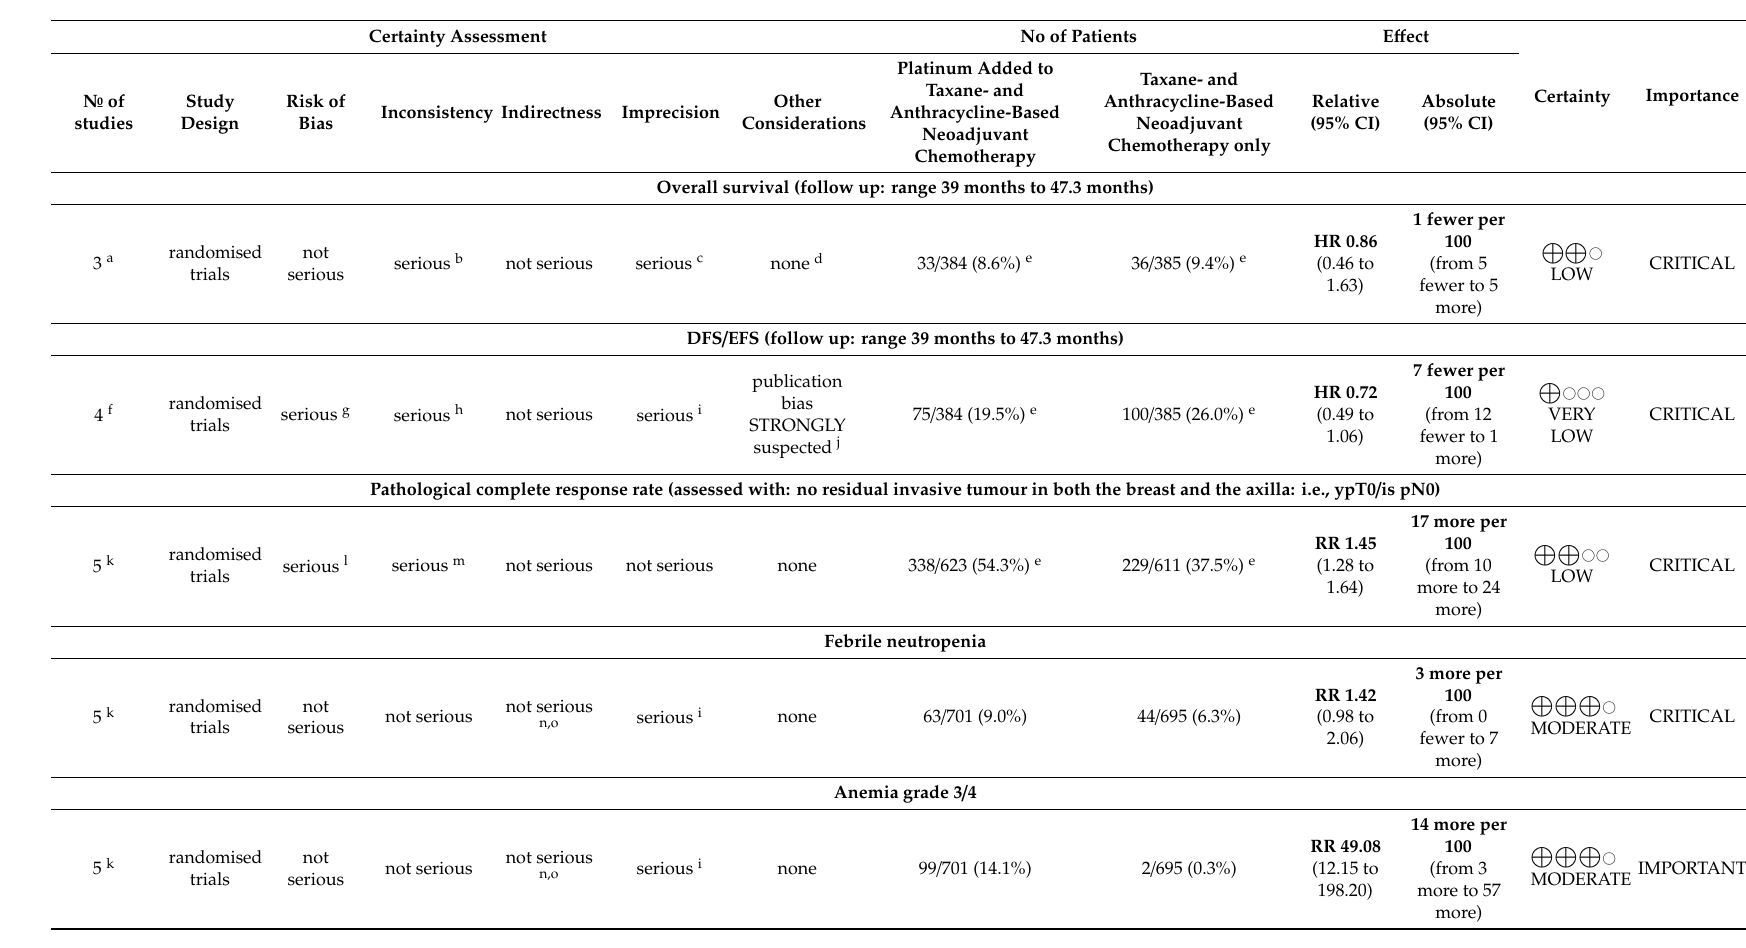
Table 2. Evidence profile table for GRADE assessment. Question : In patients with triple-negative breast cancer who are candidates to receive neoadjuvant chemotherapy, is the addition of a platinum agent to a taxane and anthracycline-containing regimen recommended versus a taxane and anthracycline-containing regimen only? Setting : inpatients. Bibliography : BrighTness [15], CALGB 40603 Alliance [16,20], GeparSixto GBG66 [17,21,22], GEICAM / 2006-03 [18], and UMIN000003355